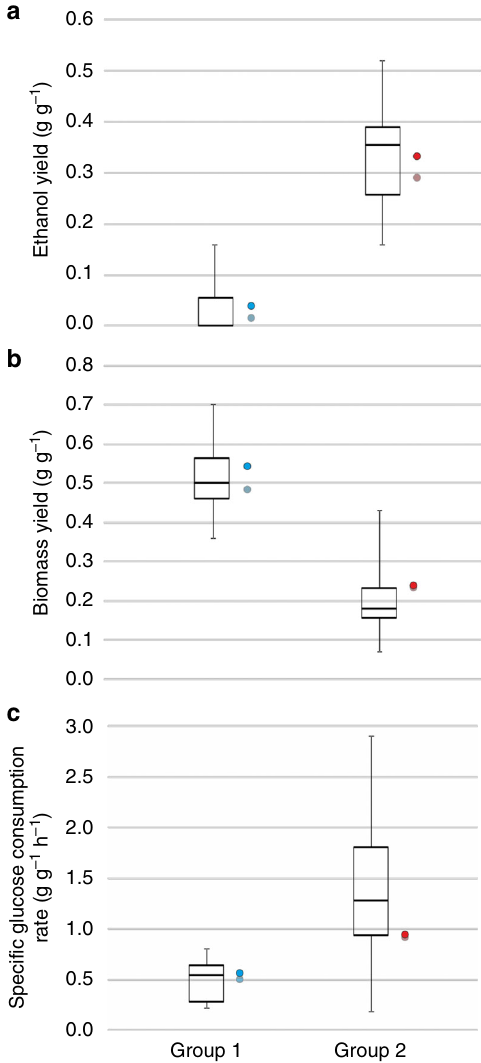
Fig. 4 The CRA1 overexpression strain classi fi es as a Crabtree-positive yeast. Classi fi cation of yeasts based on a ethanol yield, b biomass yield, and c speci fi c glucose consumption rate reveals that the control strain, K. phaf fi i (blue), belongs to Group 1 with other Crabtree-negative yeasts ( Eremothecium and Kluyveromyces genera, see ref. 26 ). K. phaf fi i CRA1 overexpression strain (red), however, is classi fi ed as a Crabtree-positive yeast with other positive yeast species ( Lachancea, Torulaspora, Zygotorulaspora , Vandervaltozyma, Tetrapisispora, Saccharomyces, Kazachstania, Naumovozyma , and Nakaseomyces genera). Values of the duplicate experiments for the control and overexpression K. phaf fi i strains are presented. The box plots are based on the data of ref. 25 . The box spans the interquartile range (second and third quartile), middle line represents the median value and whiskers show the minimum and maximum values